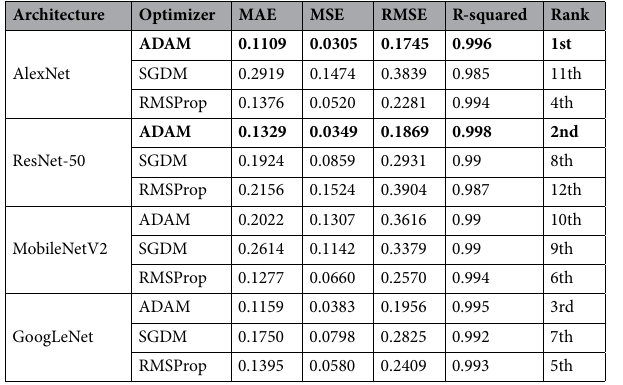
Table 6. CNN Deep Regression Model Performance on microbeads for various Architectures. Significant values are in bold.